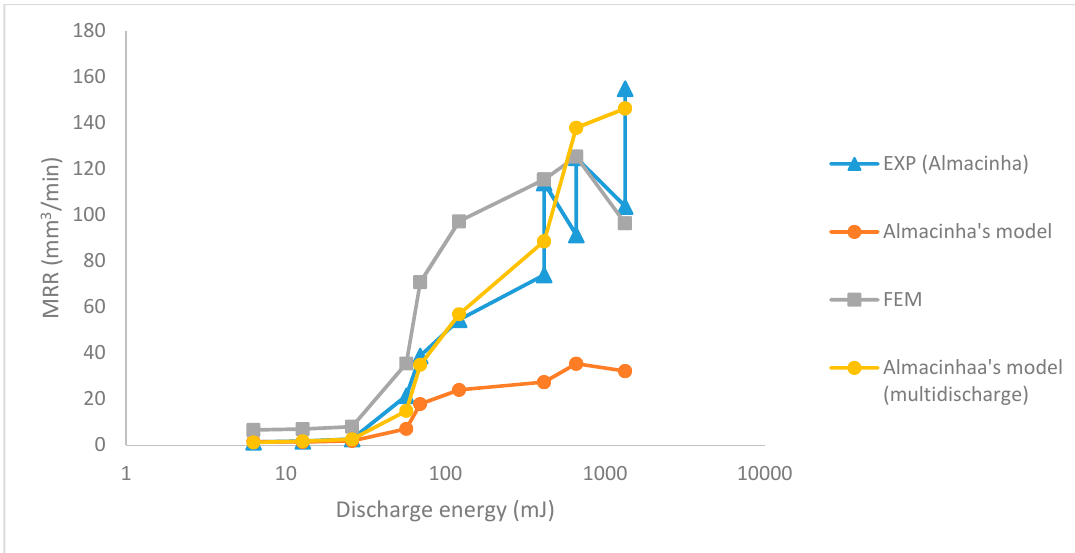
Figure 10. Comparison of MRR obtained from our numerical model with experimental values from Almacinha [22] (discharge voltage 20 V). Table 1. Performance parameters of MRR simulation.